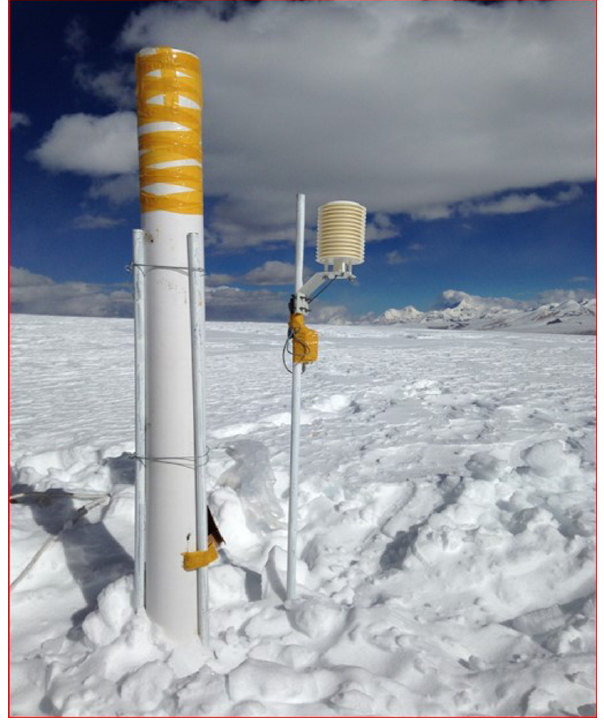
Figure 2. The equipment for collecting new snow samples from the surfaces of the seven studied TP